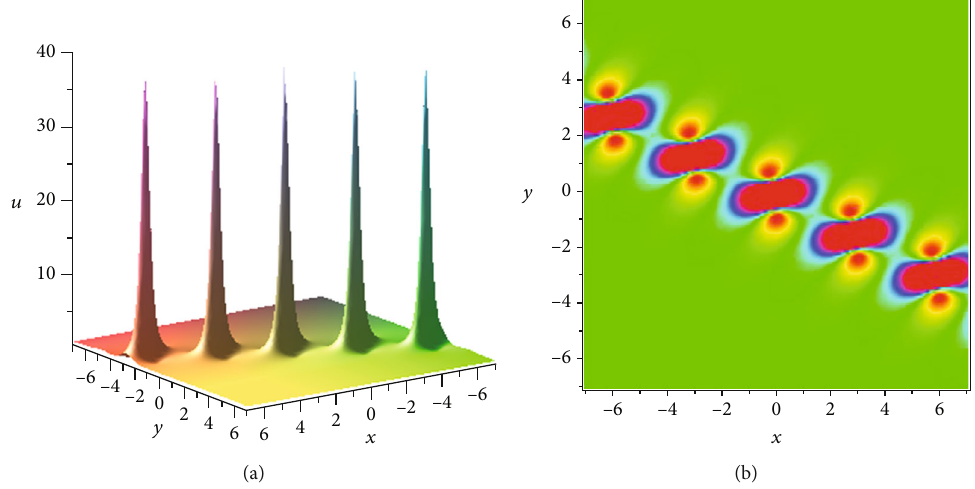
Figure 1: (a) 1-breather. (b) Density picture of 1-breather.